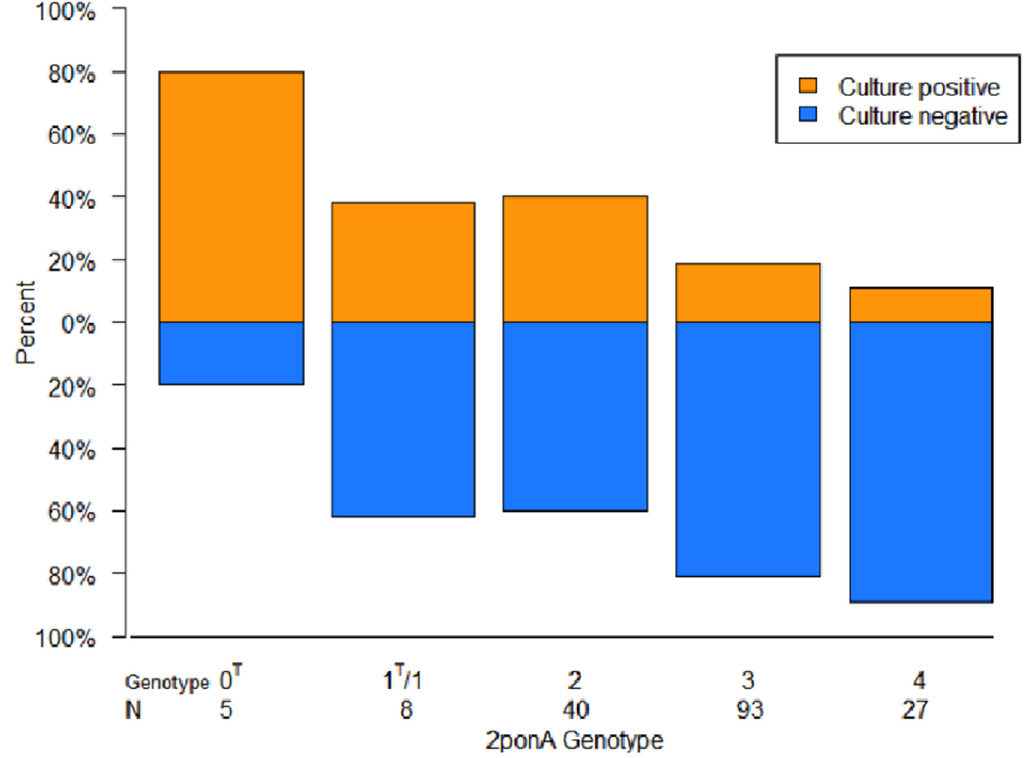
decreased with the number of Proline codon deletions (e.g. Genotype 4 = 4 Proline deletions) in the poly-Proline track in the ponA1 region targeted by the 2-ponA primer (see Fig B in S1 File) (P =